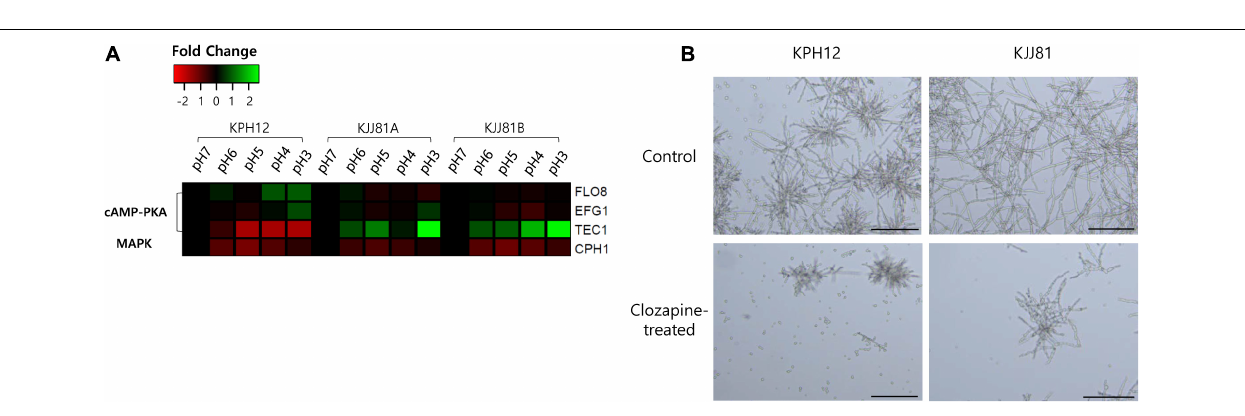
FIGURE 9 | Expression profiles of Saccharomycopsis fibuligera transcriptional activators of cAMP-PKA and MAPK, the two signaling pathways associated with the dimorphic growth of several model yeasts and fungi, at each pH point. pH 7 was considered the starting point (log 2 FC = 0), and the expression at each pH was calculated based on pH 7. (A) shows the RNA-Seq data and (B) shows the cell morphology of S. fibuligera strains in the presence or absence of the cAMP-PKA blocker clozapine. SD, starch degradation; CD, cellulose degradation; TF, transcription factor; scale bar = 100 µ